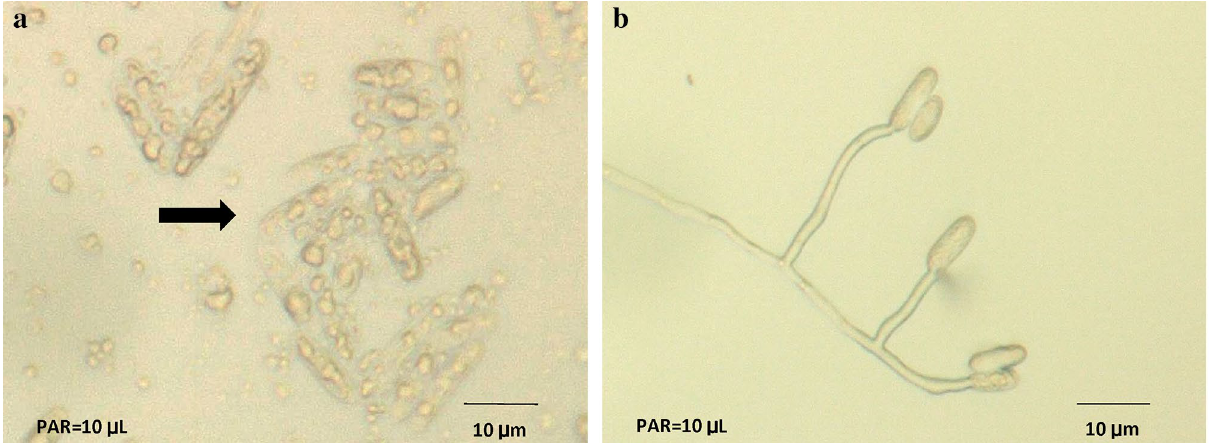
Figure 4. Spore of C. musae ( a ) treated with CWE, ( b ) untreated, 48 h after treatment